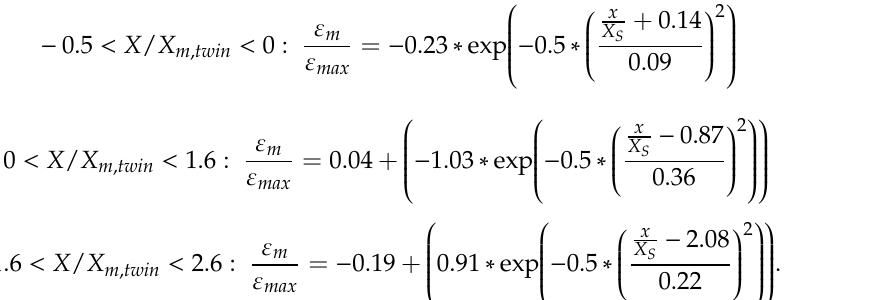
Figure 14. Comparison between the predicted equation and previous research.